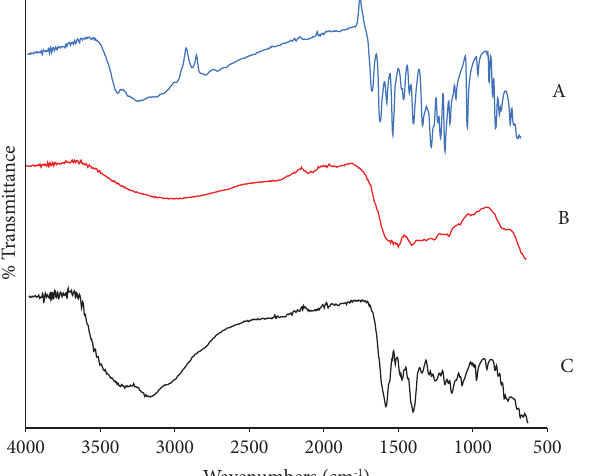
Figure 3: Te infrared study of quercetin (a), quercetin-zinc (b), and quercetin-iron (c). Te characteristic band of quercetin showing the OH group, CH 2 /CH asymmetry, C � O, and C-O bond was observed in respective complexes.